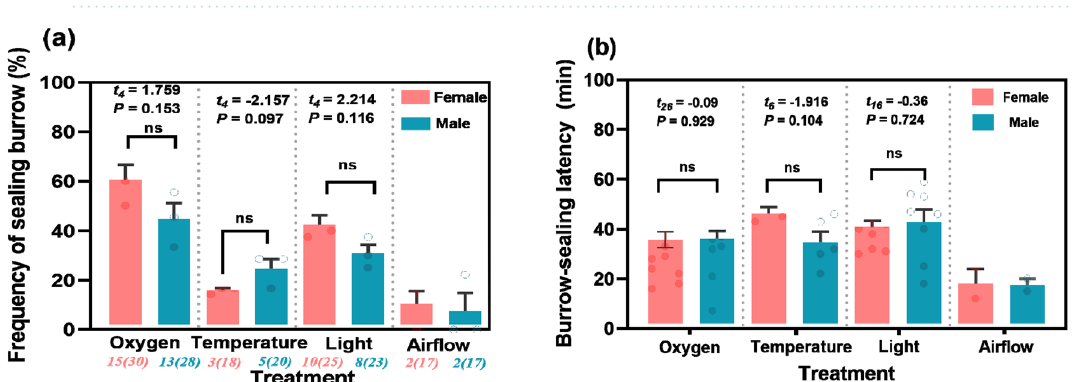
Figure 5. The frequency of burrow-sealing and the latency to reseal the burrow in response to different treatments. The upper and lower horizontal lines of the boxes represent the maximum and minimum values, respectively. The black plus signs and the central horizontal lines represent the mean and median, respectively. Different colored dots in ( a ) represent the number of zokor individuals (N = 6), while in ( b ) they represent the number of burrow-sealing events. The left-hand values of the pairs of italic numbers in brackets on the horizontal axis in ( b ) denote the number of burrow-sealing events, while the right-hand values are the number of experiments. The results of the statistical tests are displayed in the text. Different lowercase letters indicate a significant difference ( P < 0.05), while the same lowercase letter indicates a non-significant result.